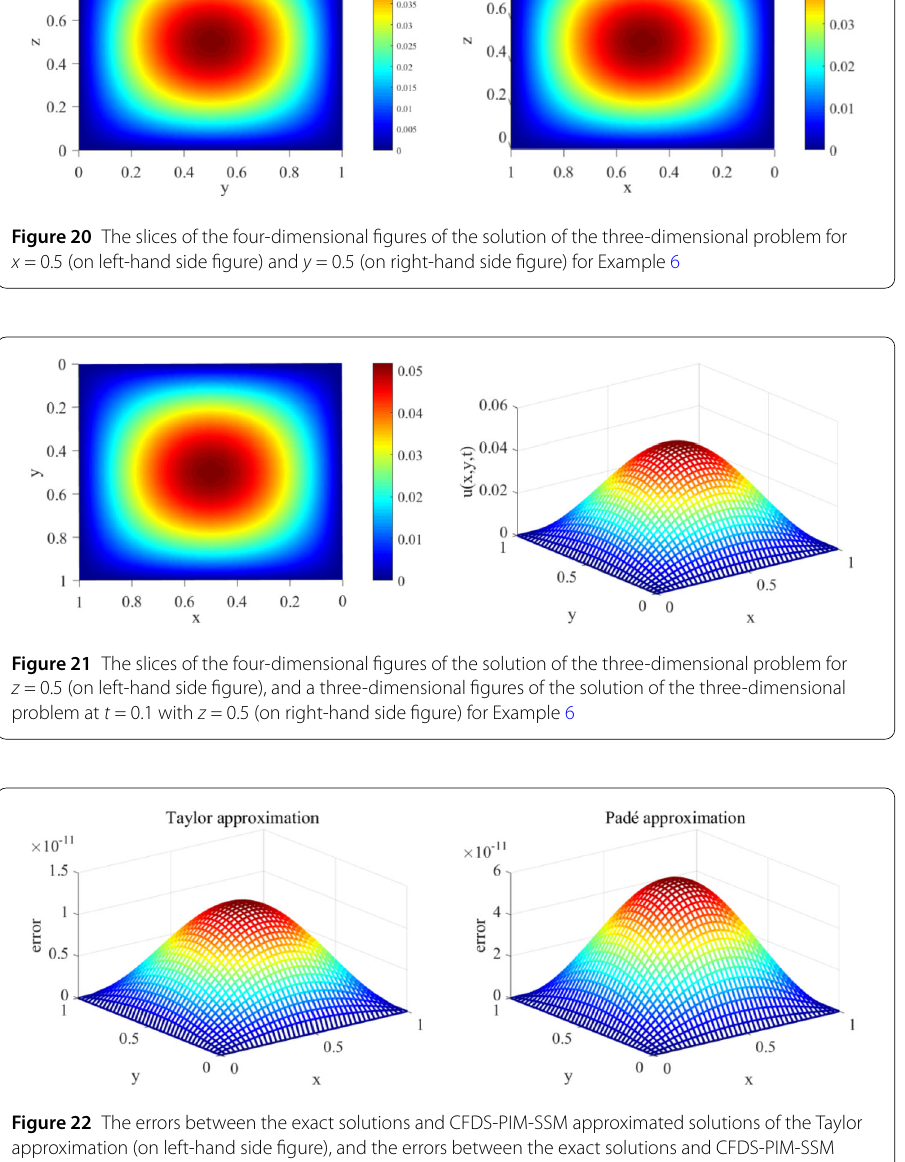
more accurate than the Padé approximation. There is the phenomenon in Table 9 that the convergence order will decrease with the increase of nodes. Zhai et al. [41] gave an expla- nation for this phenomenon. The convergence order is formally defined when the mesh size approaches zero; therefore, when the mesh size is relatively large, the discretization schemes may not achieve the formal convergence order. Besides, because the mesh size is extremely small, the Padé approximation scheme cannot achieve its formal convergence